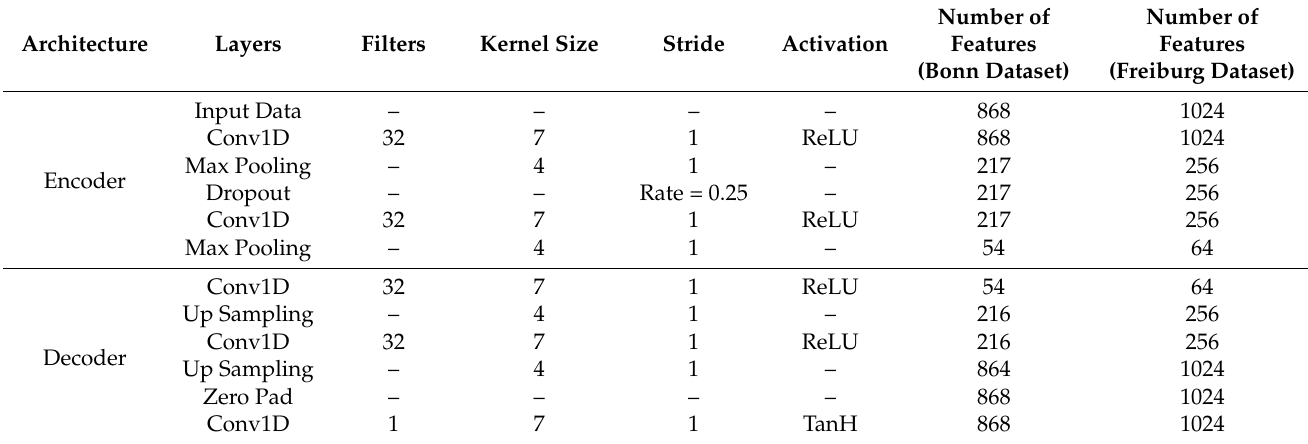
Table 5. Details of proposed CNN-AE